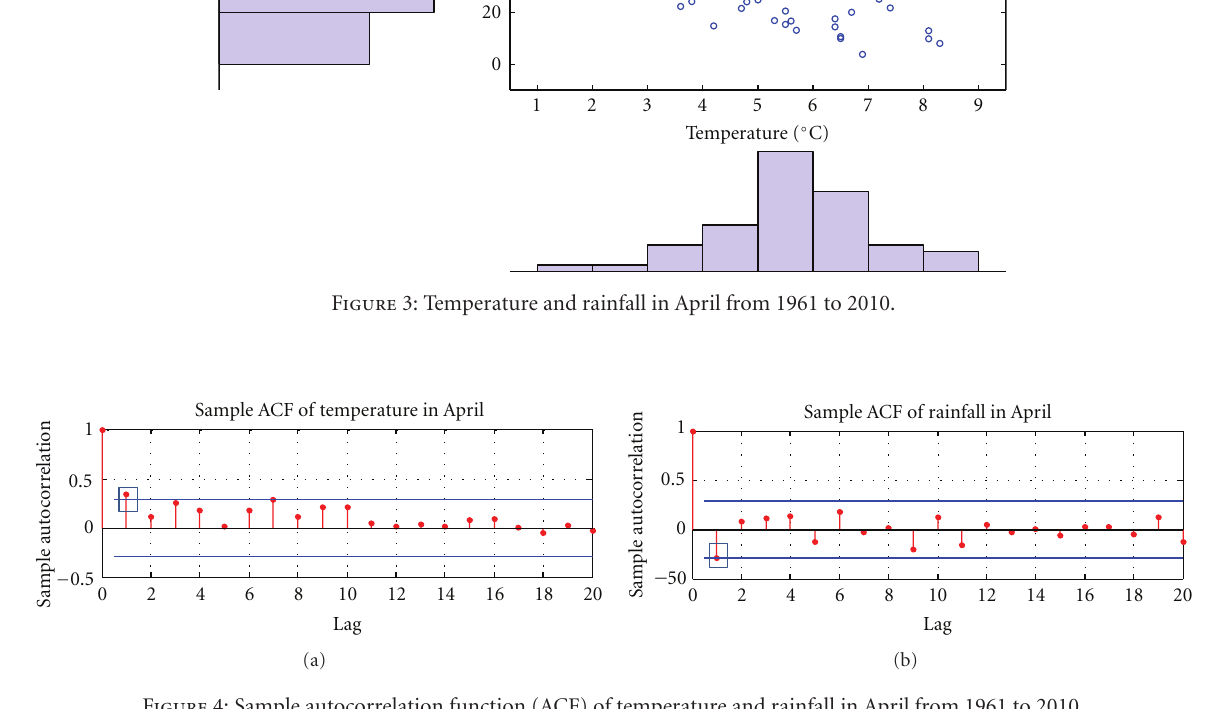
Figure 4: Sample autocorrelation function (ACF) of temperature and rainfall in April from 1961 to 2010.